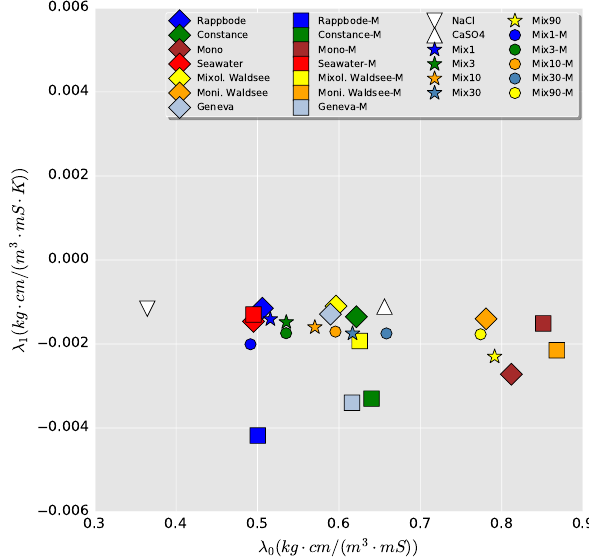
Figure 2. Distribution of the values of λ 1 vs. λ 0 . Concentrations for NaCl and CaSO 4 are 1gL − 1 in both cases. Chemical compositions for the lakes and seawater are presented in Table 1. The water sam- ples labelled as “Mix” are proportional mixtures of KCl, NaHCO 3 , and Na 2 SO 4 of 1, 3, 10, 30 and 90gL − 1 (Gomell and Boehrer, 2015) and the water samples labelled as “-M” correspond to the lambda coefficients obtained from direct measurements of density and